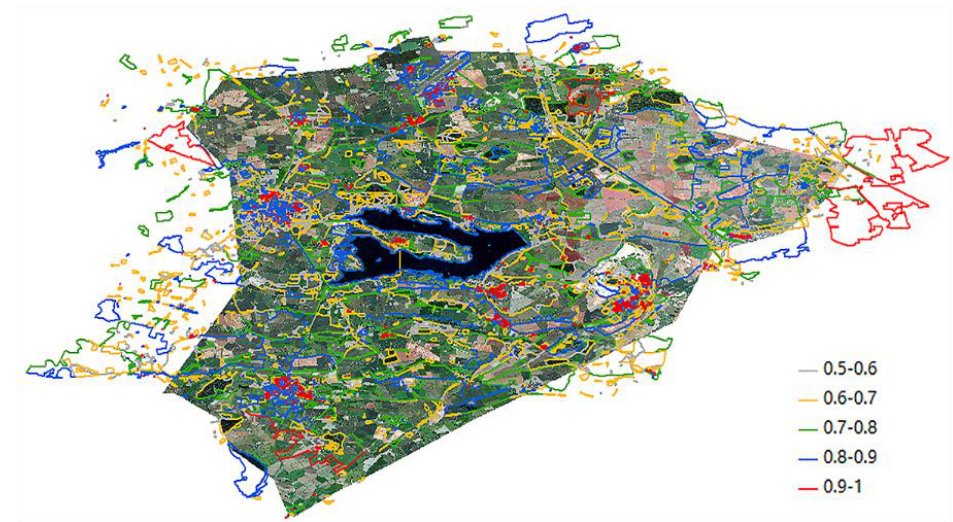
Figure 7. G raph of contributor’s reputation distribution map. Figure 7. Graph of contributor’s reputation distribution map.